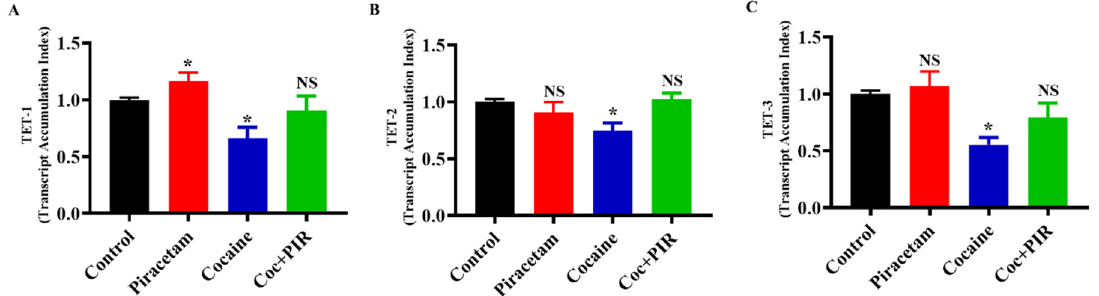
Figure 5. Piracetam reversed the impact of cocaine on TET gene expression. Human primary astrocytes (2 × 10 6 cells / mL) were exposed to cocaine (1 µ M) and / or piracetam (10 µ M) for 24 h. The mRNA expression of ( A ) TET-1, ( B ) TET-2 and ( C ) TET-3 was determined by qRT-PCR analysis. The housekeeping gene β -actin was used as a loading control. The results are expressed as the mean ± SD of the TAI of three independent experiments. * p < 0.05, NS—nonsignificant.